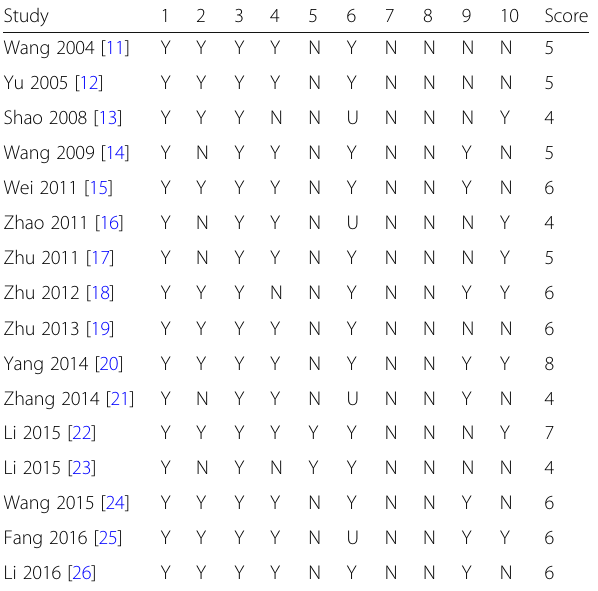
Table 2 Methodological quality assessment of the included studies